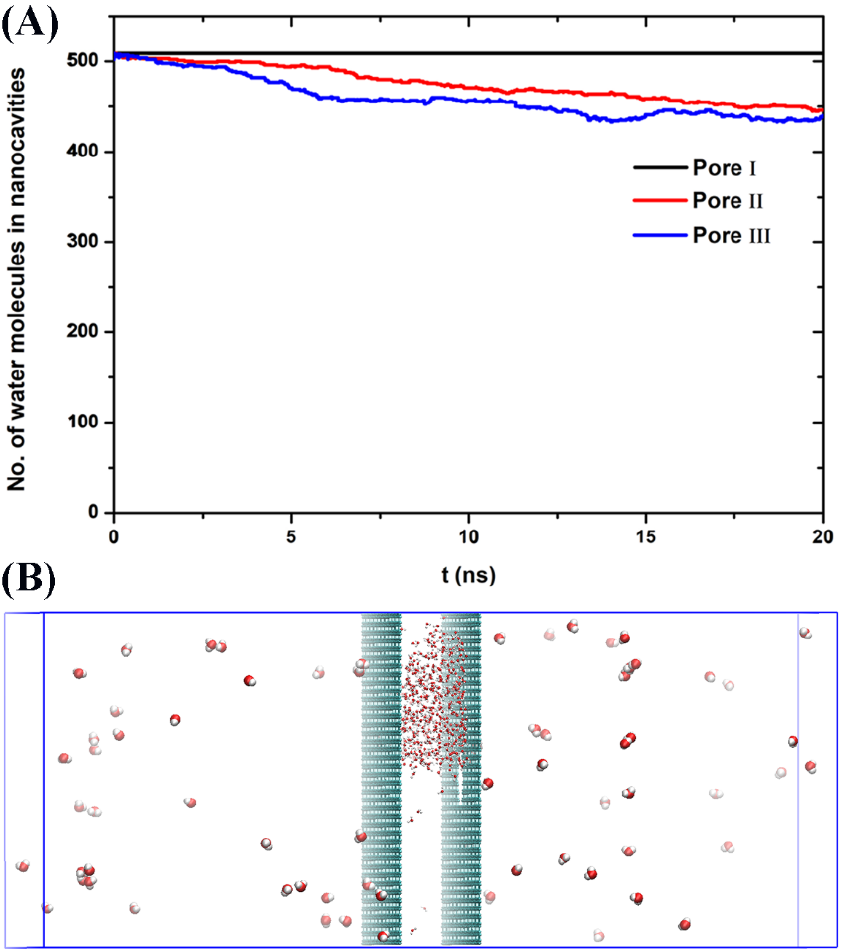
Figure 2. ( A ) The number of water molecules between the graphene walls at 423 K during the simulation for Pore-I, Pore-II, and Pore-III, respectively. ( B ) The side view snapshot of the simulation system for the case of Pore-III at 423 K. Gray spheres represent carbon atoms and red spheres and green spheres represent the oxygen and hydrogen atoms of a water molecule, respectively. The big spheres represent the water in vacuum chamber. The vacancy on graphene represents the nanopore in Figure 2B.